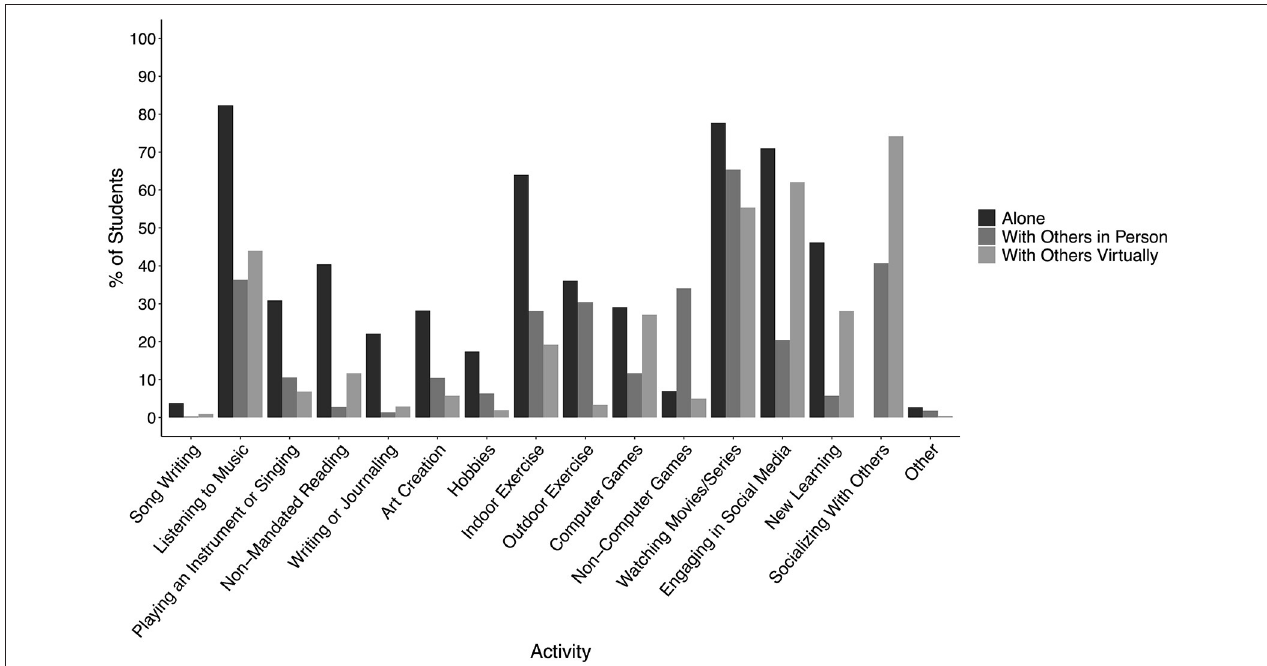
FIGURE 2 | Percent of students out of 786 who reported engaging in each extra-curricular activity alone, with others in person or with others over the internet. Note that students could engage in a particular activity in more than one